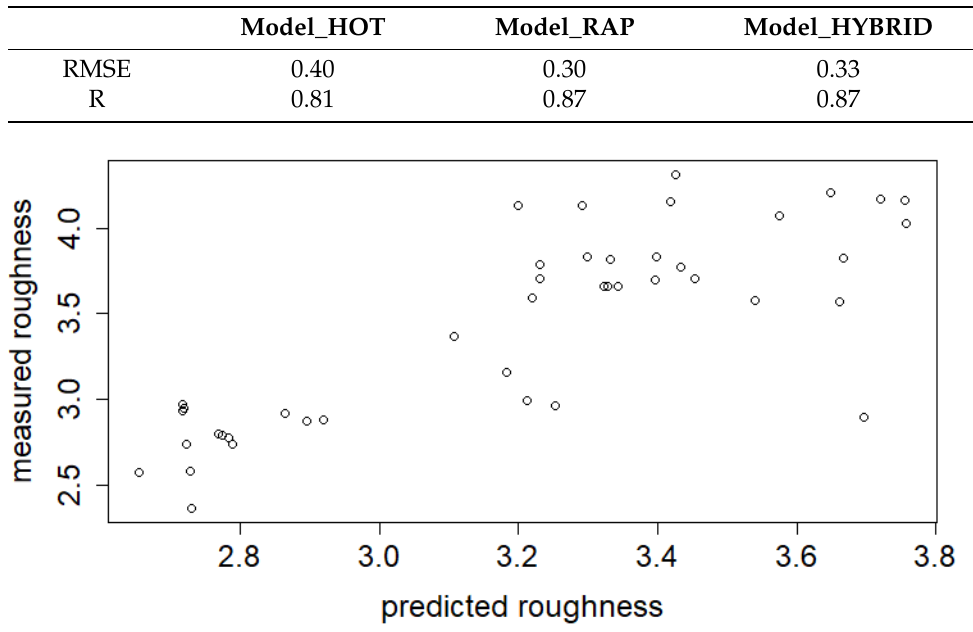
Table 1. Root mean squared errors (RMSEs) and correlations (R) of the models in test set.